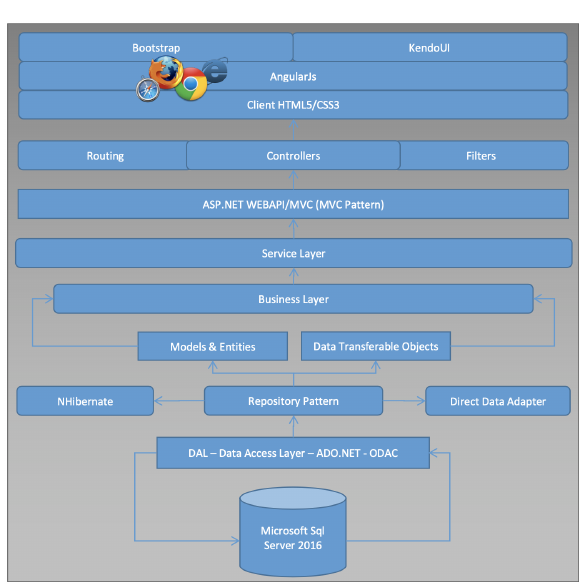
Figure 5. The software